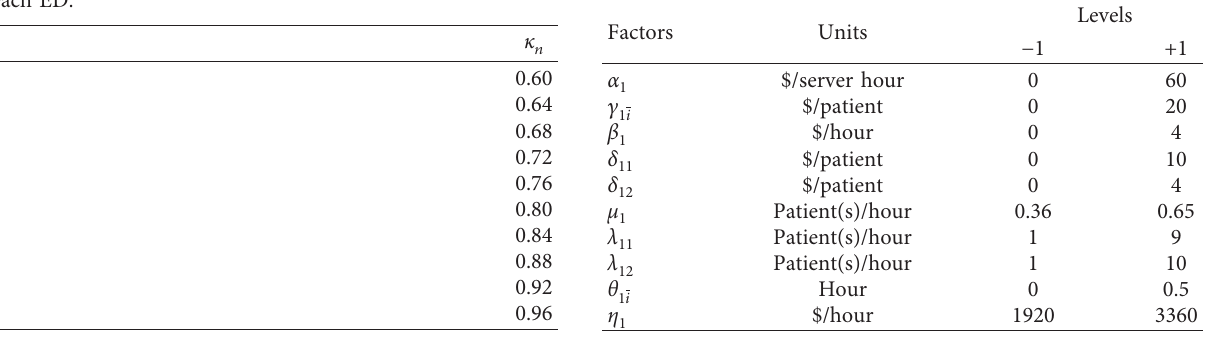
Table 3: DOE design factors and their